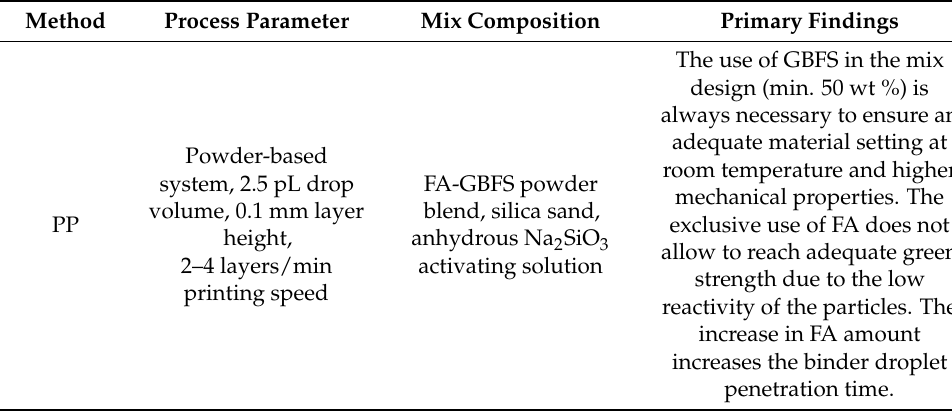
Table 8. Details of [91] research